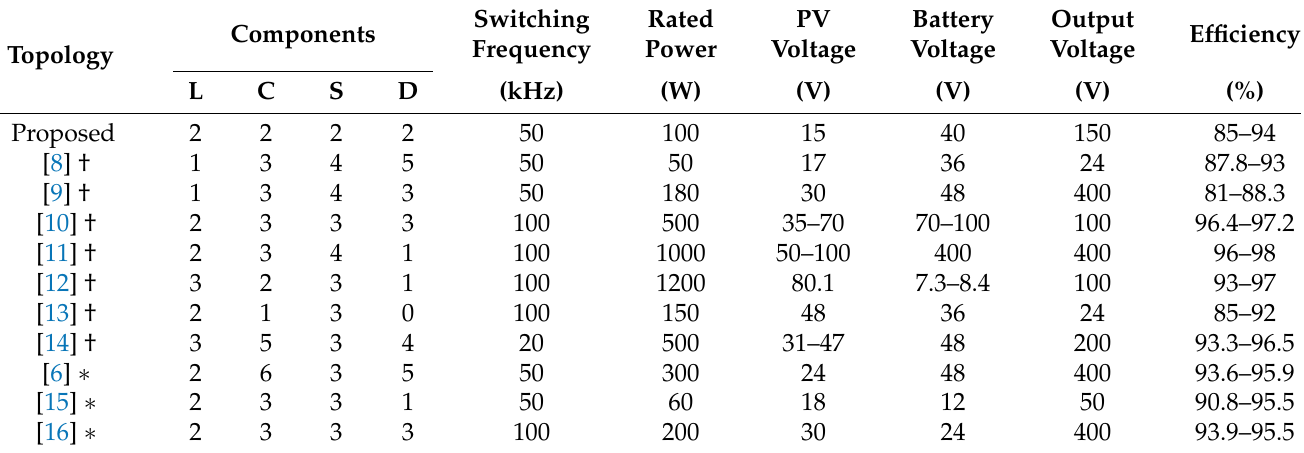
Table 1. Comparison with similar